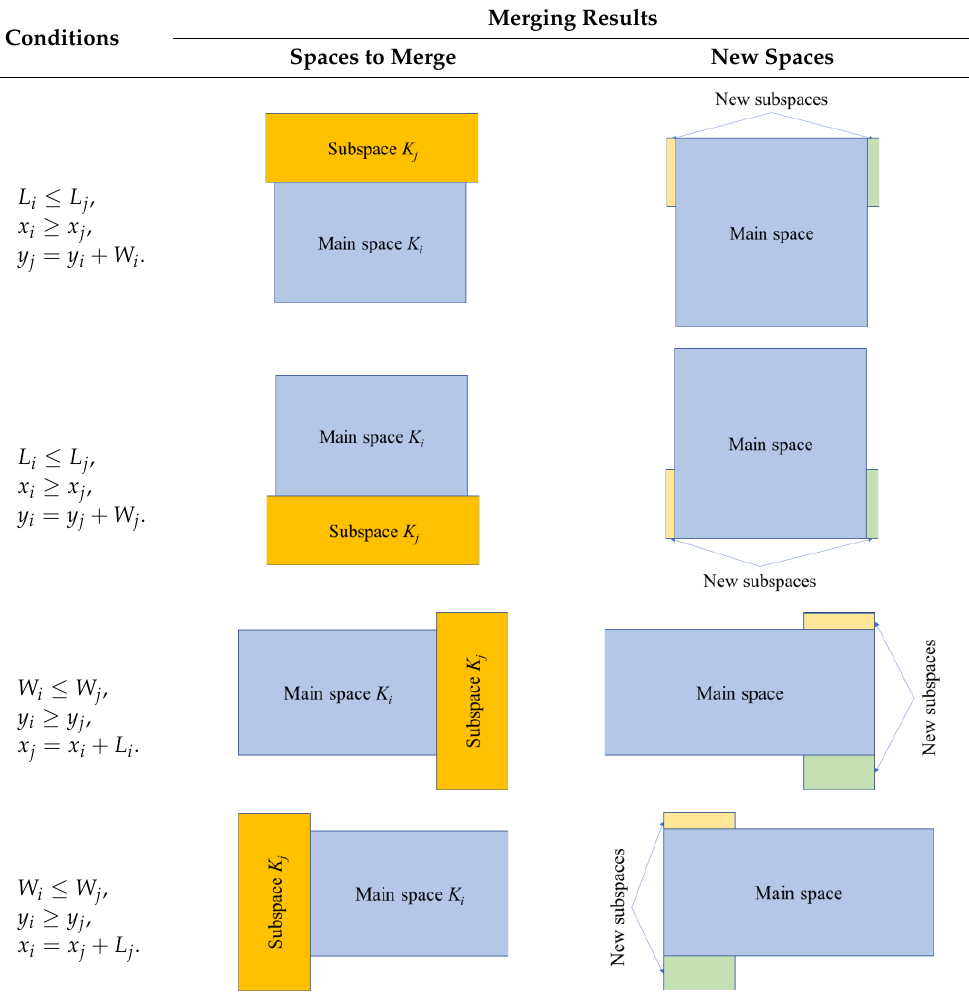
Table 4. Merging the secondary spaces into main spaces. Merging Results Conditions Spaces to Merge New Spaces